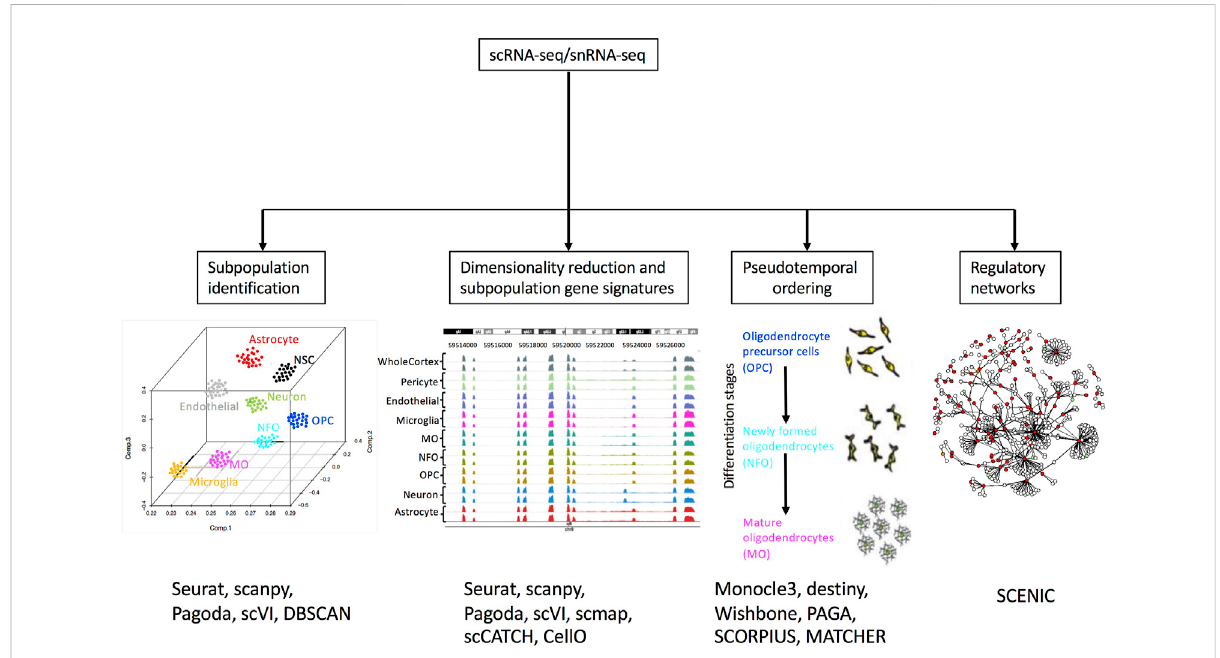
FIGURE 3 Overview of scRNA-seq and snRNA-seq downstream analysis. Examples of relevant software tools used for each application are included. References to example tools are listed in Supplementary Table S2. Adapted from (Cuevas-Diaz Duran, Wei and Wu, 2017) © Cuevas-Diaz Duran, Wei and Wu,